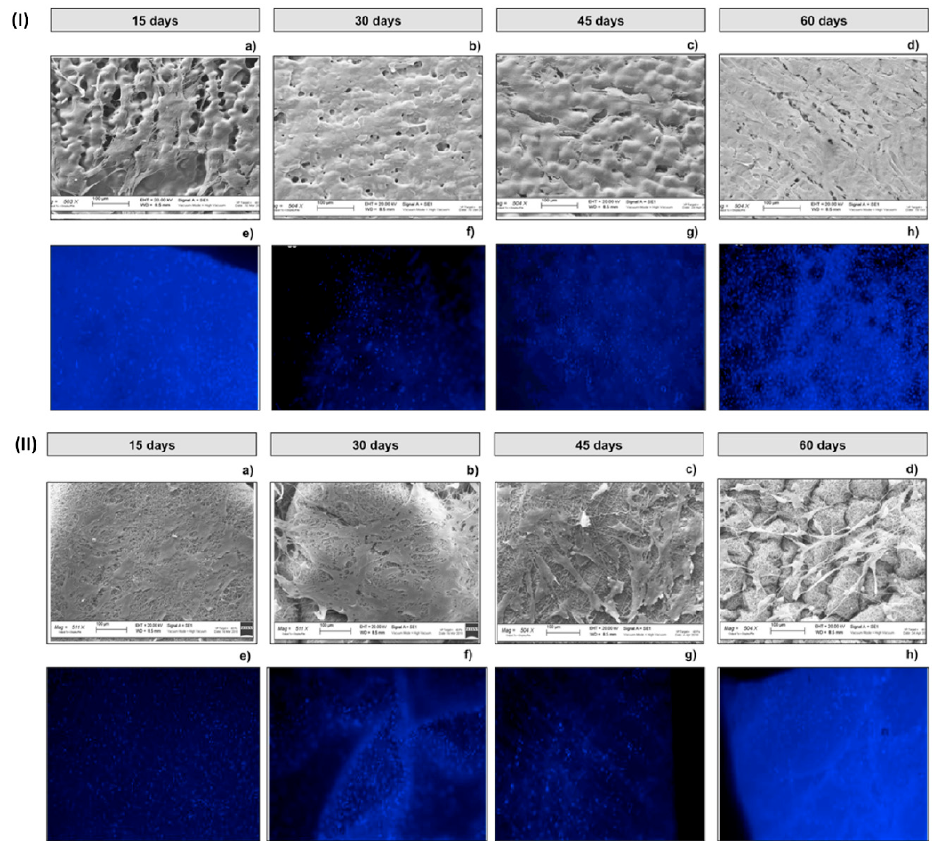
Figure 6. TIP-Fs ( I ) and EL-Ms ( II ) characterization during cellularization in floating conditions. SEM micrographs ( a – d ) and confocal images ( e – h ). Confocal analyses have been performed after DAPI